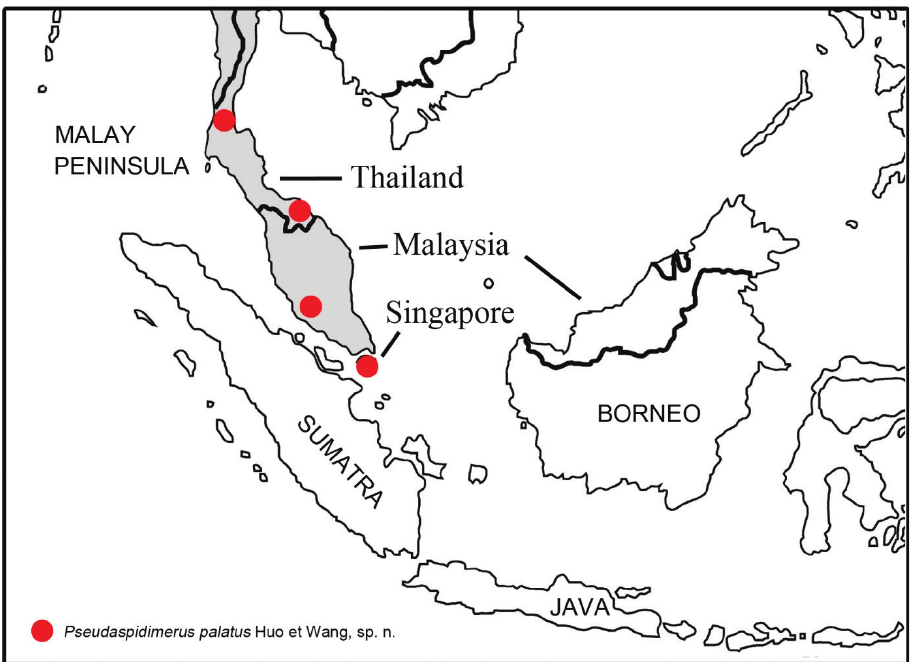
Figure 3. Distribution map of Pseudaspidimerus palatus Huo & Wang, sp. n.